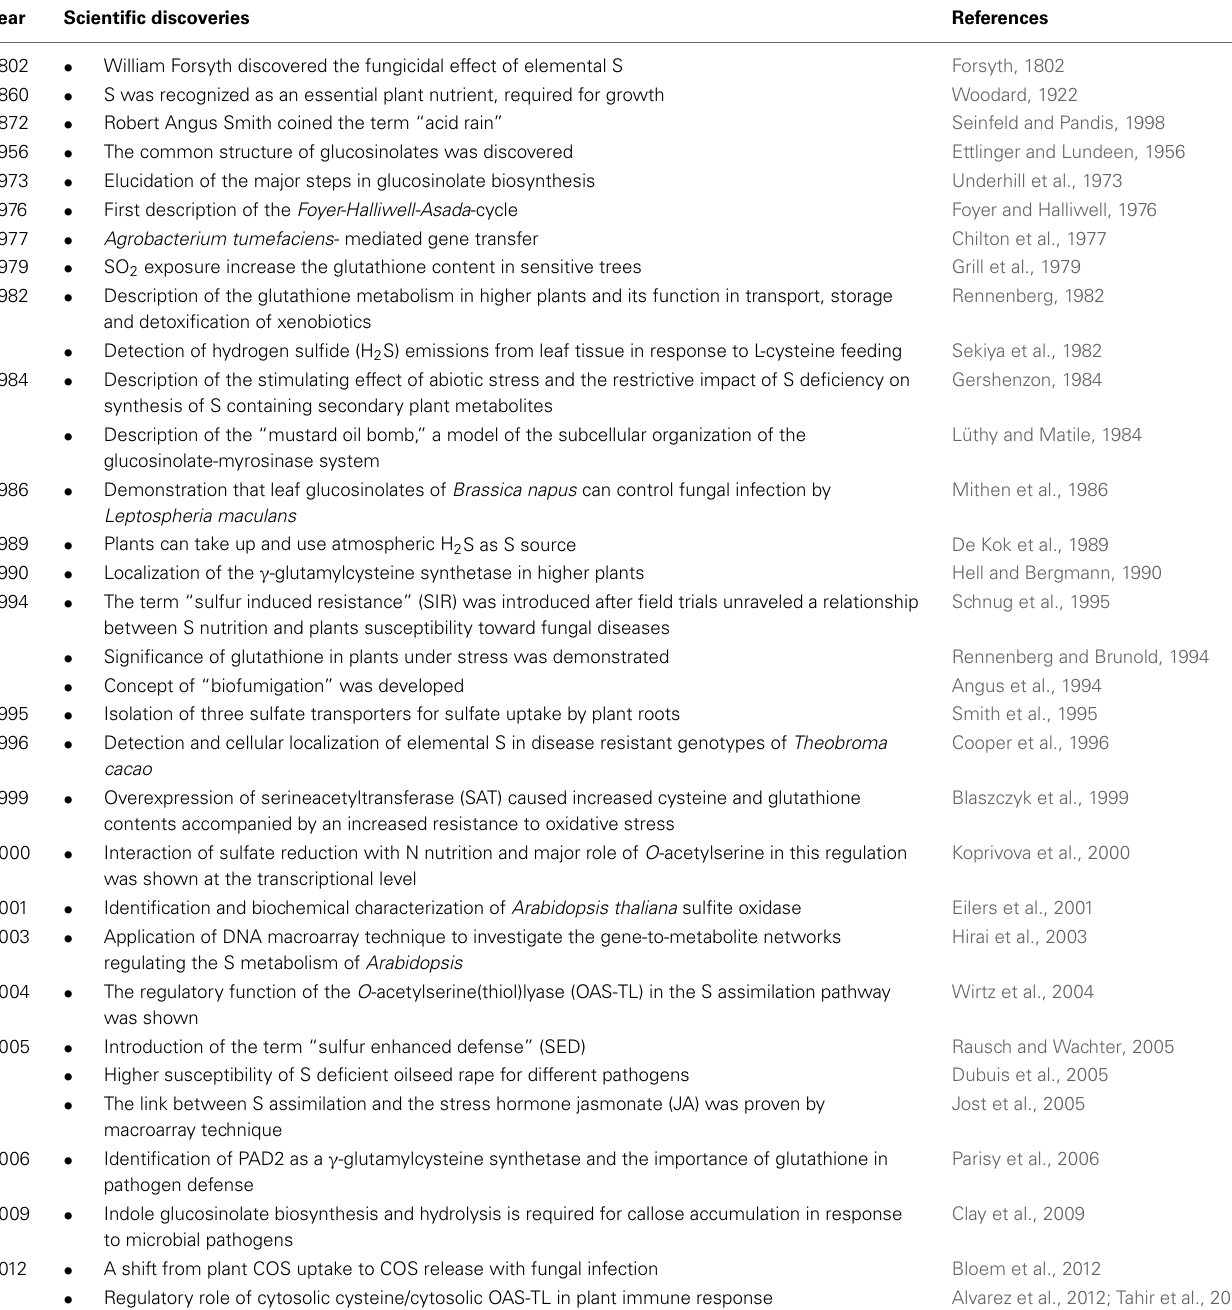
Table 1 | Discoveries and progress in plant sulfur (S) research with respect to sulfur induced resistance (SIR) during the twentieth century.